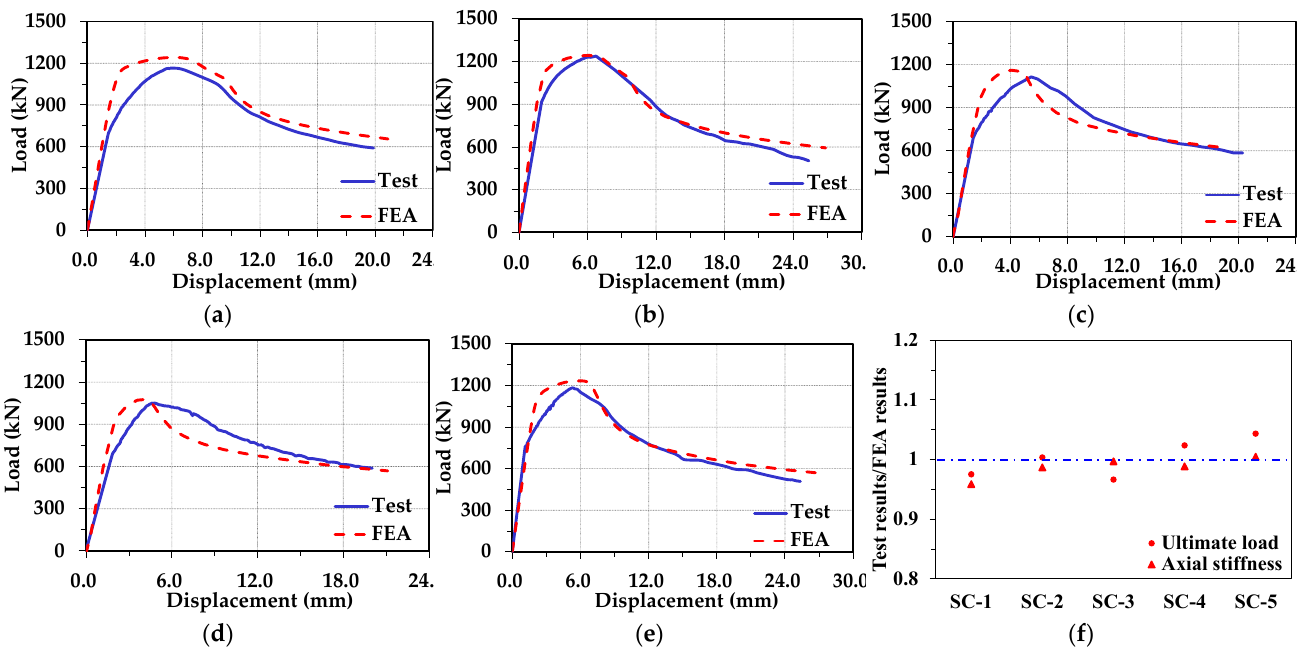
Figure 16. Comparisons of load-displacement curves: ( a ) Specimen SC-1; ( b ) Specimen SC-2; ( c ) Specimen SC-3; ( d ) Specimen SC-4; ( e ) Specimen SC-5; and ( f ) comparisons between results of FEA and tests.